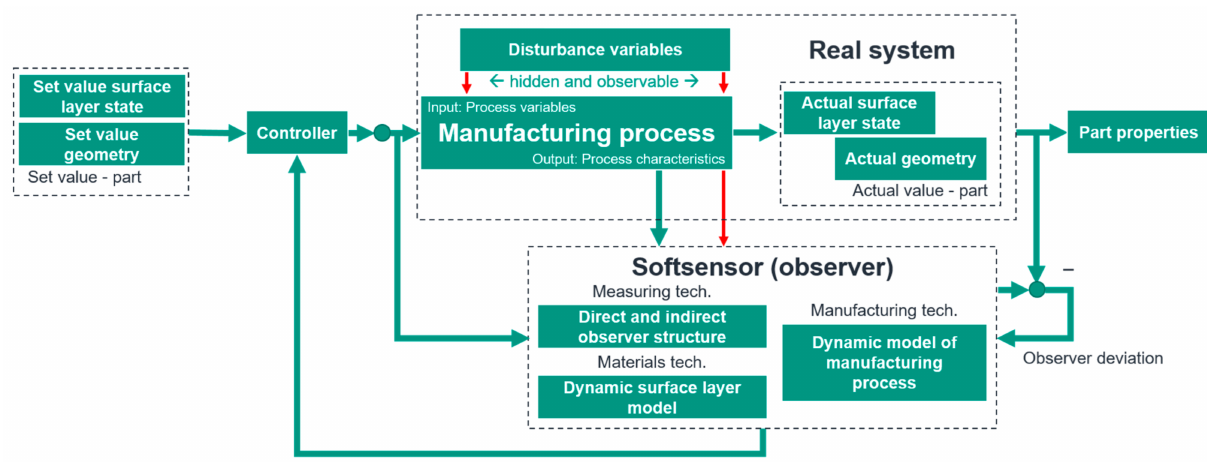
Figure 1. Generic scheme of a surface focused process